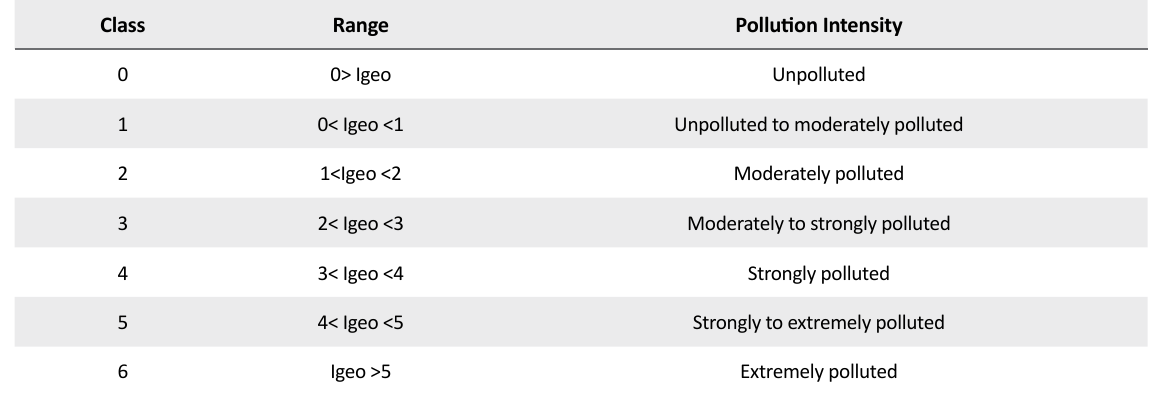
Table 1. Classification of geo-accumulation index based on pollution intensity